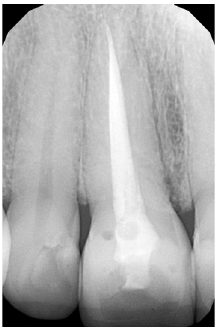
Figure 1. RVG image showing the endo-treated teeth.